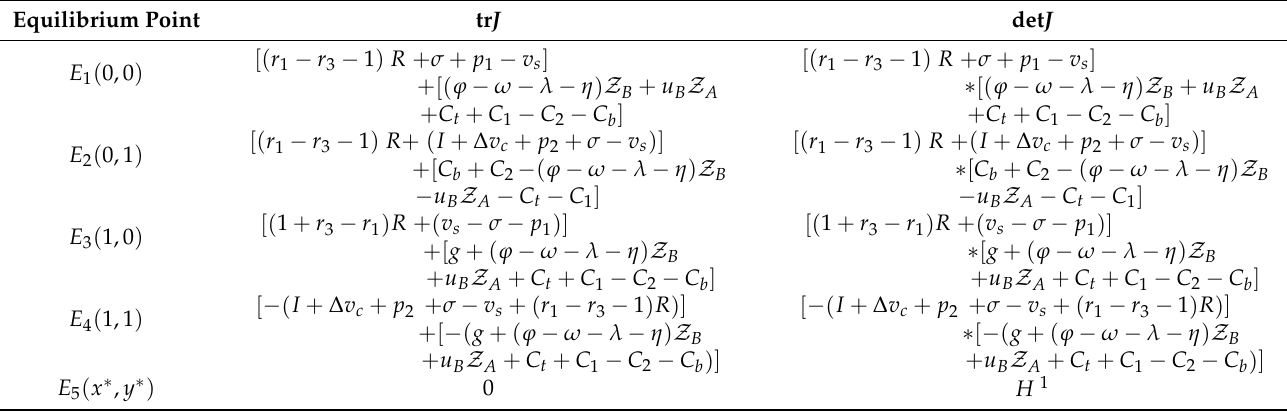
Table 3. The analysis table for judging the stability of equilibrium